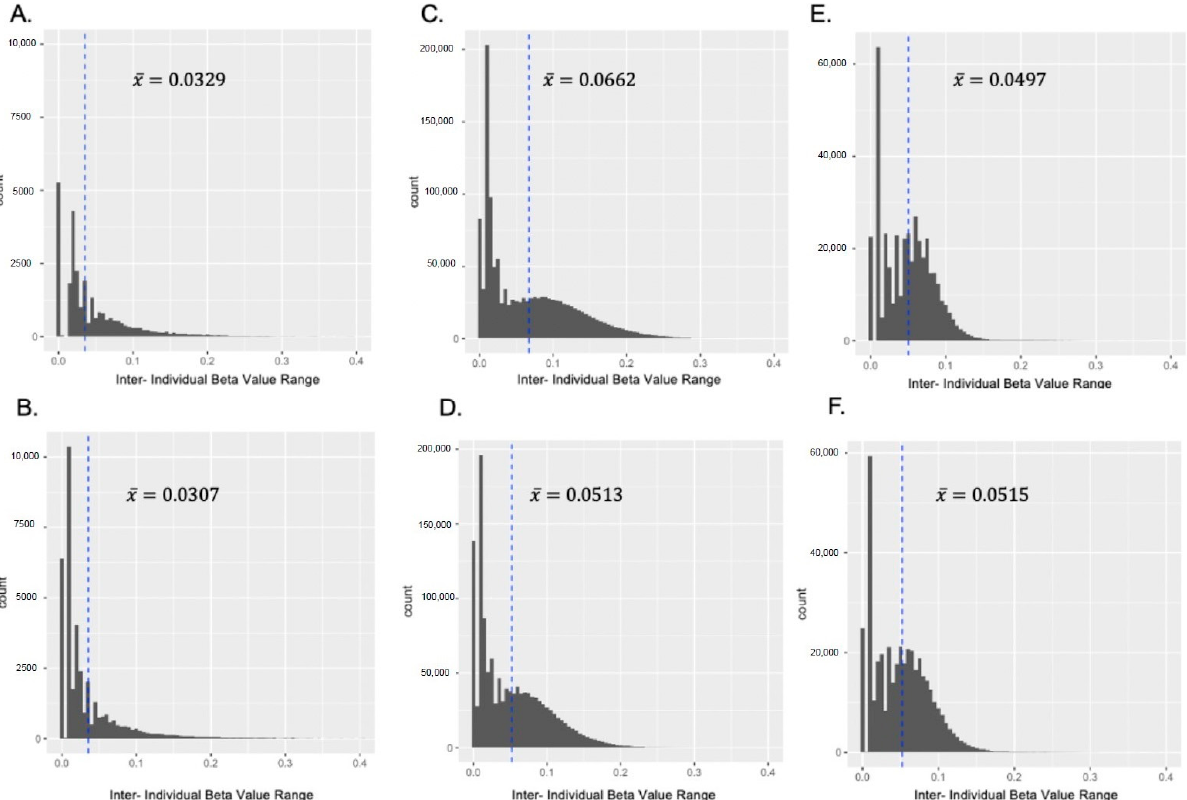
Figure 2. Histograms of the inter-individual beta value ranges for the cytosine-phosphate-guanine sites across the genome in the ( A ) Control amygdala, ( B ) Prenatally Stressed (PNS) amygdala, ( C ) Control anterior pituitary ( D ) PNS anterior pituitary ( E ) Control leukocytes, and ( F ) PNS leukocytes. The dashed lines represent the mean inter-individual beta value ranges.